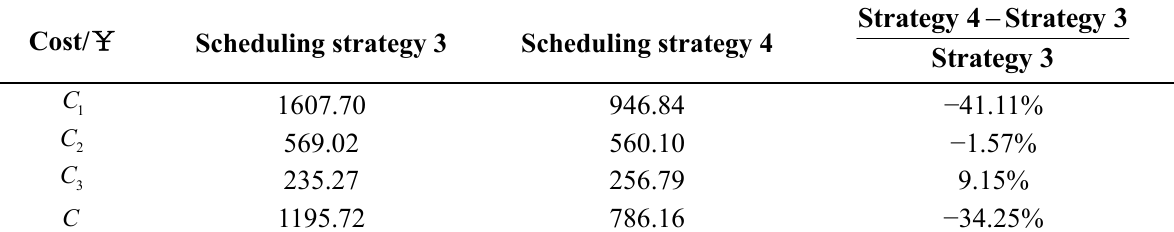
Table 7. Island mode: cost of dispatch results under different